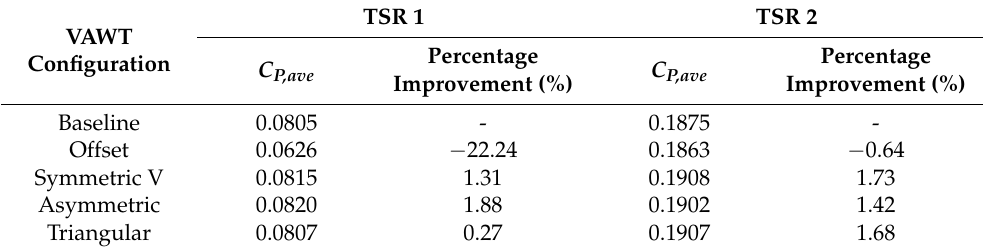
Table 3. Cycle-averaged C P performance at TSRs 1 and